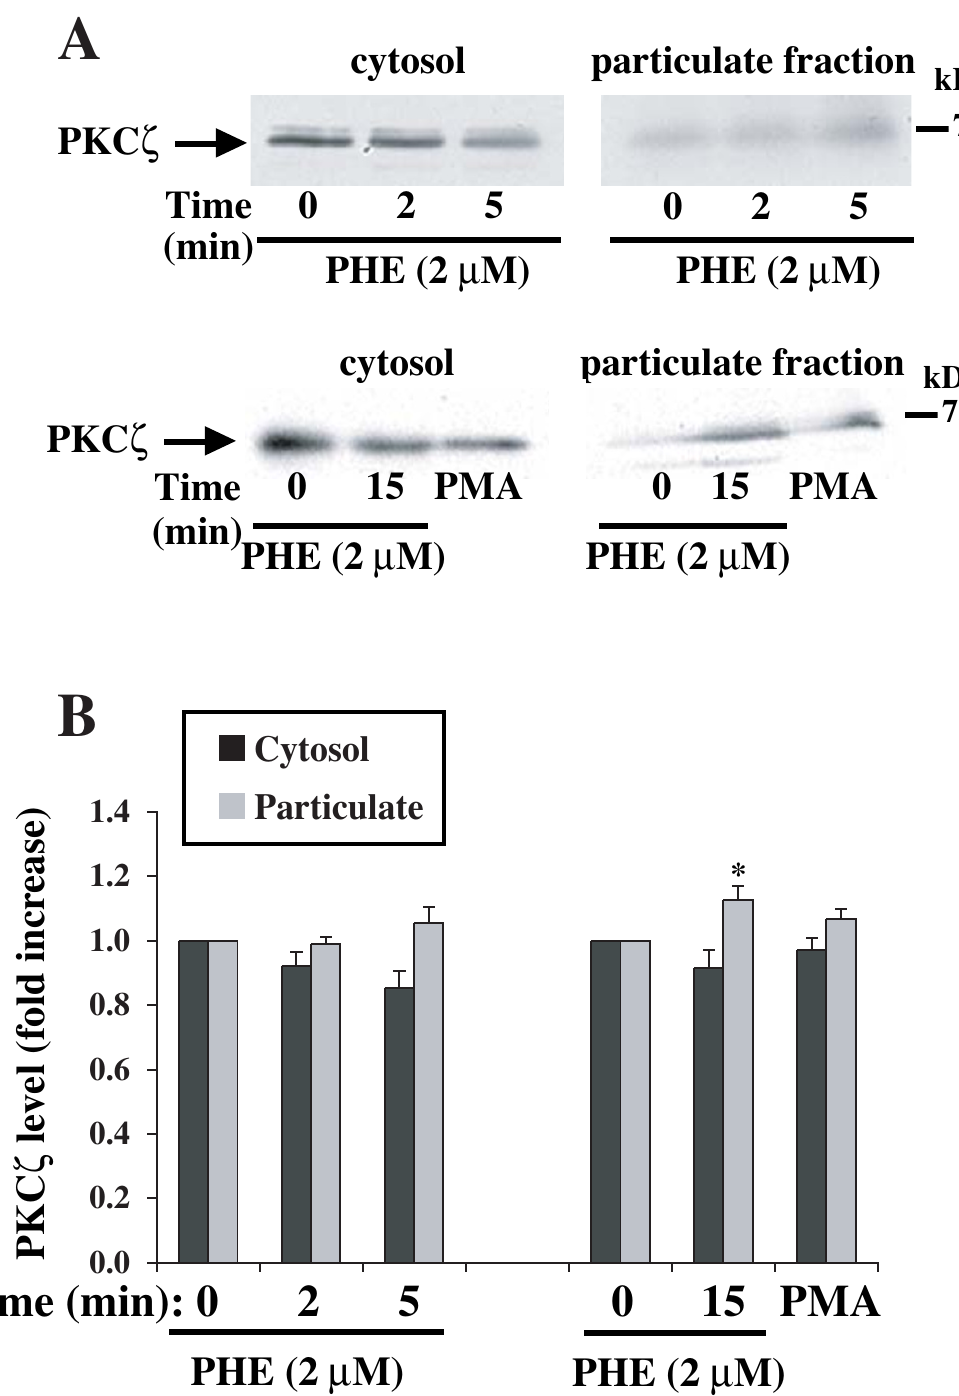
Figure 3 Effect of PHE and PMA on PKC ζ localization in rat-1 fibroblasts. Serum-deprived cells in DMEM were treated with 2 µ M PHE or 1 µ M PMA for 2, 5, 10 and 15 min, lysed and cytosol and particulate fractions were subsequently prepared as described in methods. A representative Western blot is shown in A. The bar graph (B) represents quantitation of the PKC ζ protein bands by densitometric analysis of blots from five different experiments. * Value significantly different from time = 0 (cytosol or particulate), p <